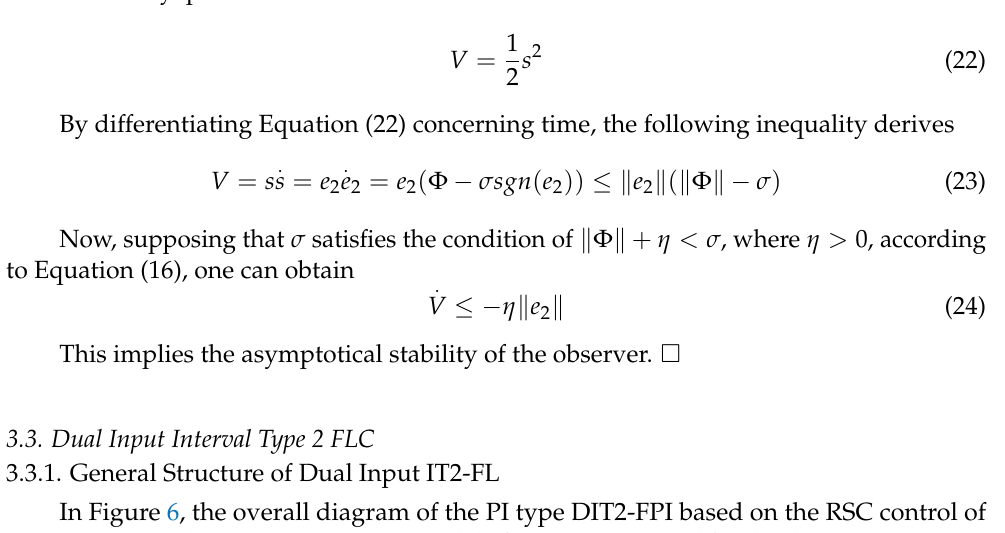
Figure 6. Diagram of DIT2-FPI controller.